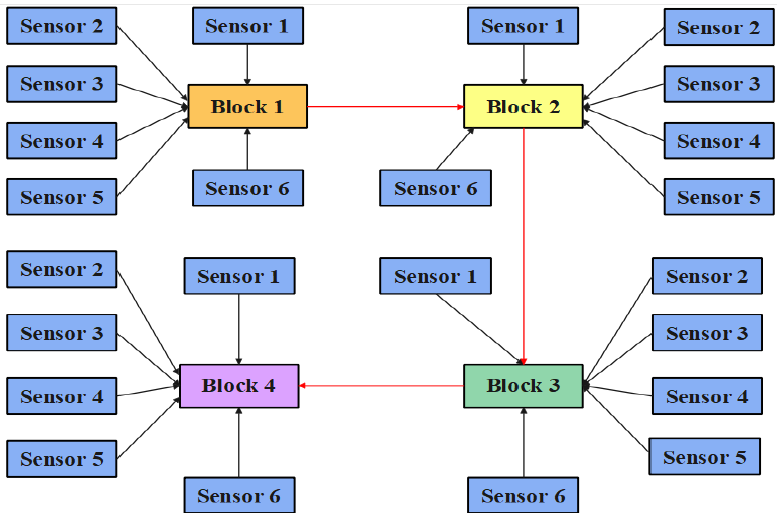
Figure 4. WSN blockchain technology.